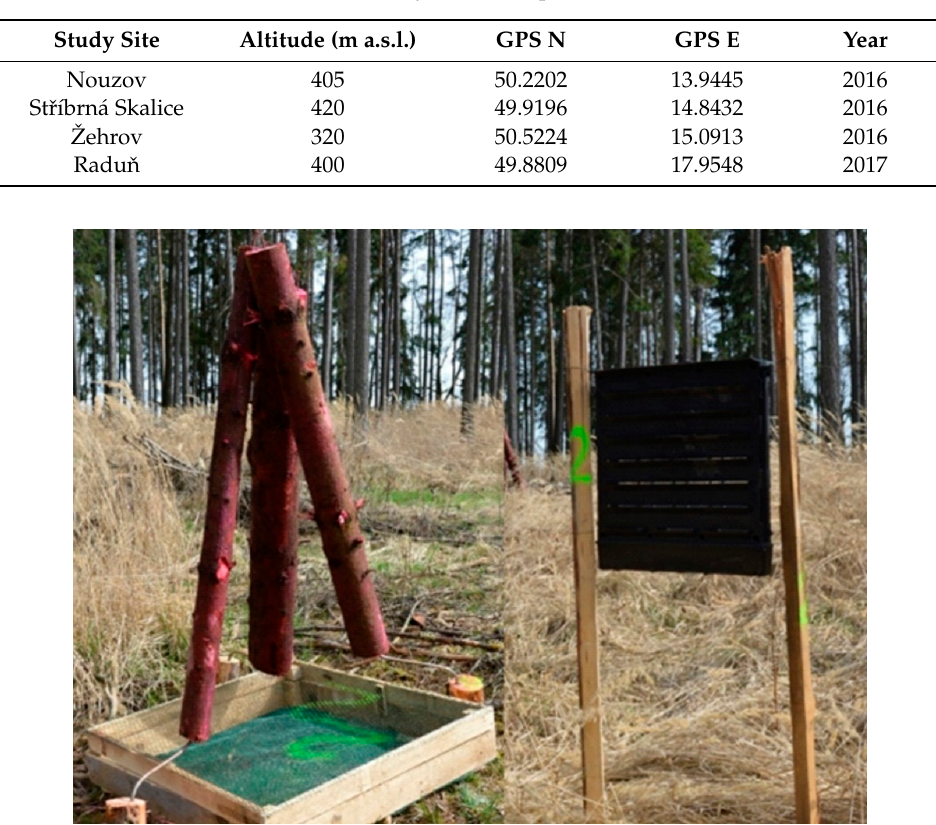
Figure 4. Baited tripod ( left ) and pheromone trap ( right ) at the Nouzov study site in 2017 (experiment 4). Photograph by Resnerová.